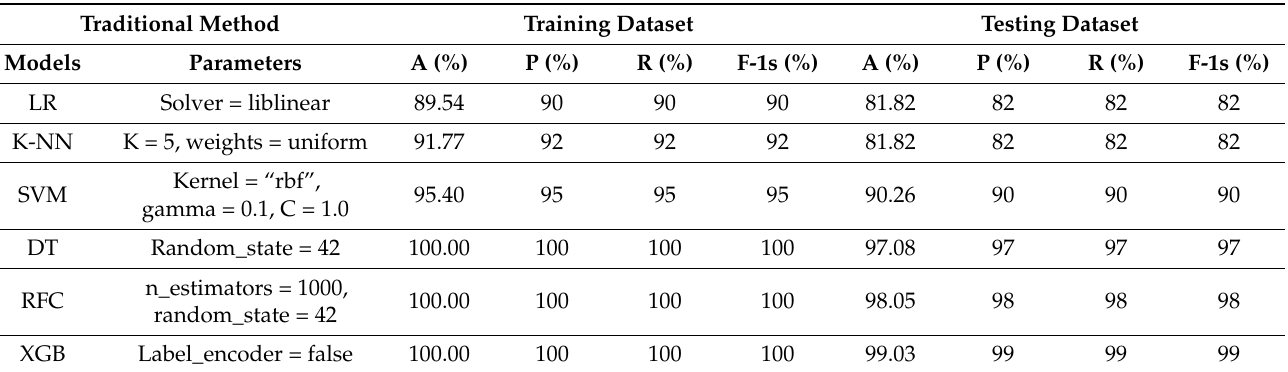
Table 8. For both the training and testing datasets, classification models were evaluated and compared after using dataset-II.